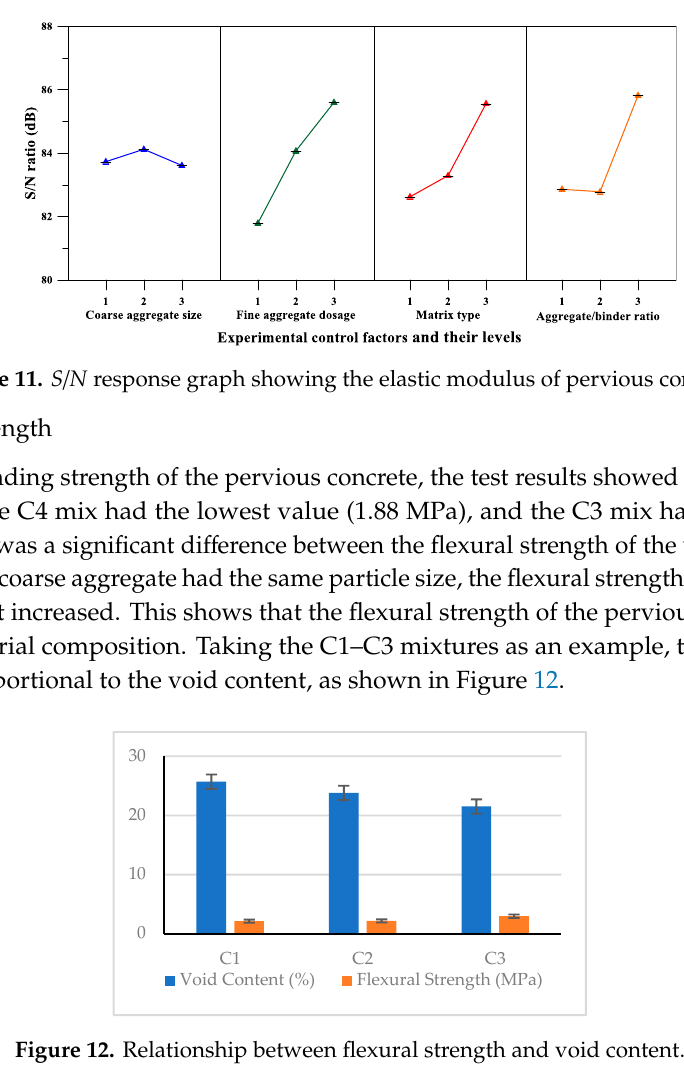
Figure 13. S / N response graph showing the flexural strength of pervious concretes.